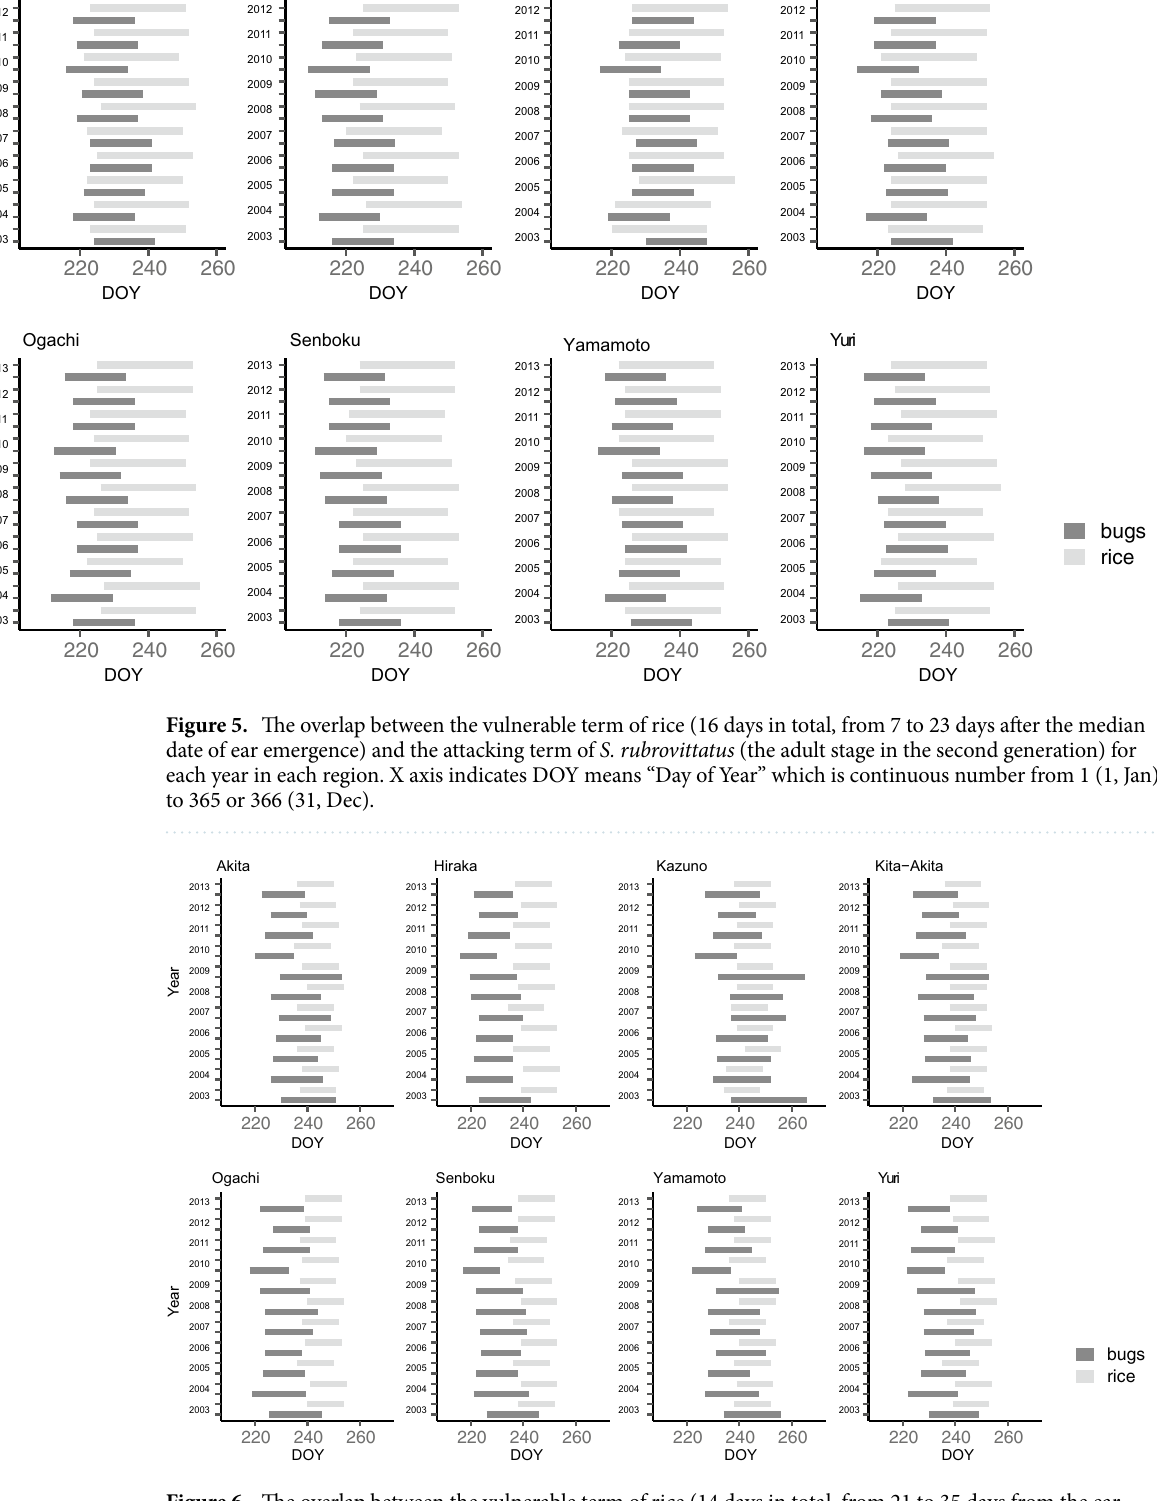
Figure 6. The overlap between the vulnerable term of rice (14 days in total, from 21 to 35 days from the ear emergence date) and the attacking term of T. caelestialium (the nymphal stage) for each year in each region. X axis indicates DOY means “Day of Year” which is continuous number from 1 (1, Jan) to 365 or 366 (31,